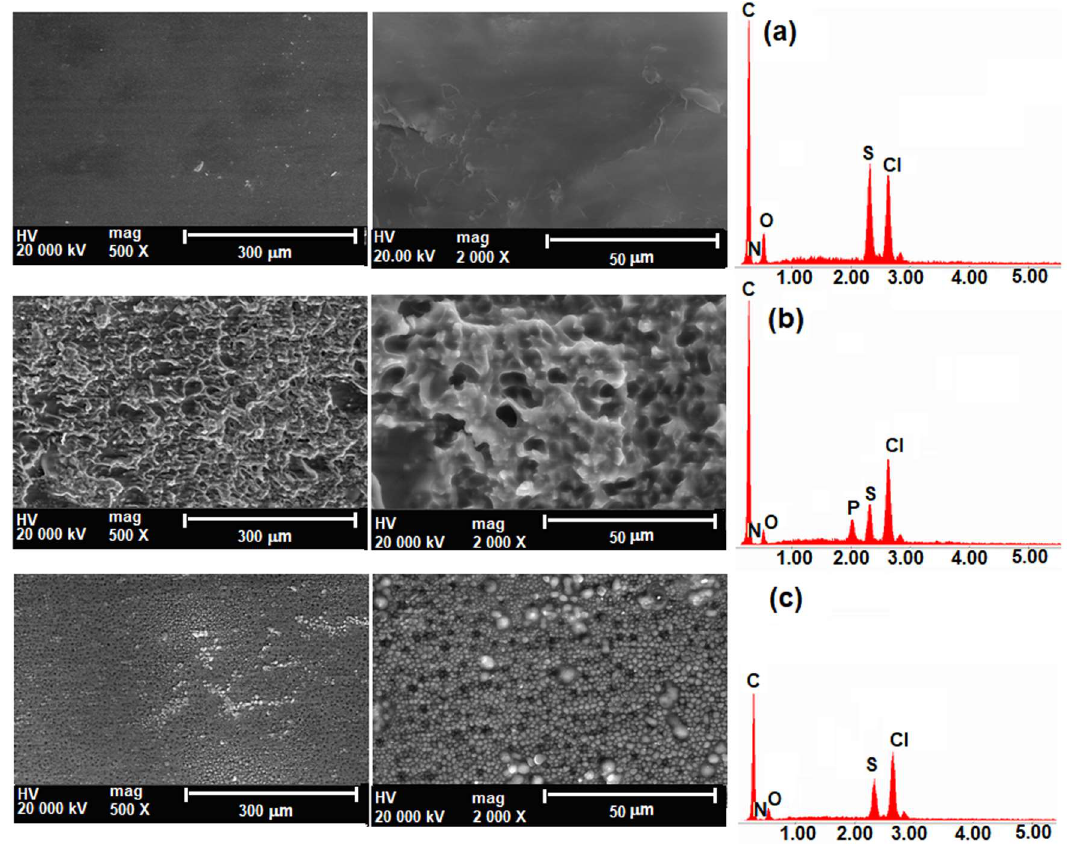
Figure 5. SEM images and EDX spectra of the membranes studied: ( a ) P0, ( b ) PIM-Ph 5 wt%, and ( c ) PIM-Am 15 wt%. Table 1. Characteristics of the membranes